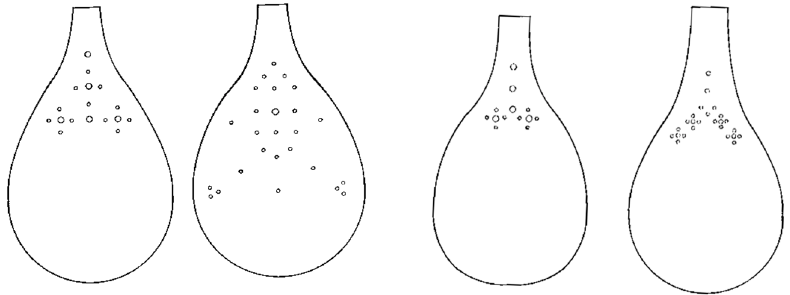
Figure 8. Conventional types of setar sound ‐ hole patterns.